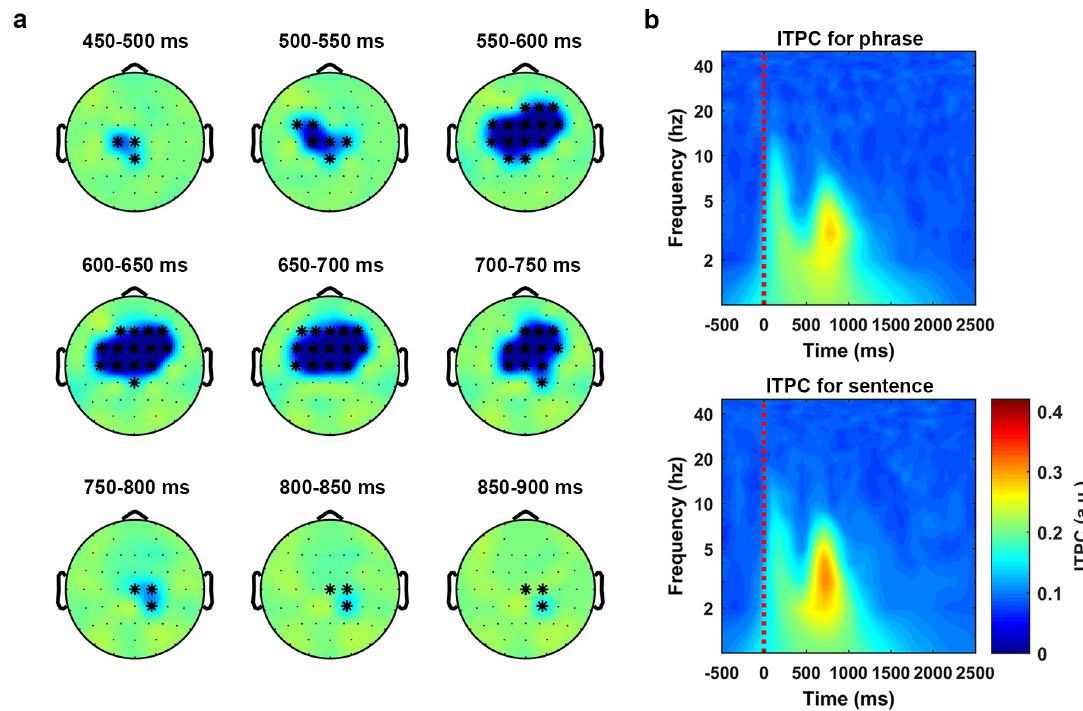
Fig 2. Phase coherence separates phrases and sentences at theta band. Statistical analysis on the phase coherence (ITPC) was conducted using a nonparametric cluster-based permutation test (1,000 times) on a 1,200-ms time window, which started at the audio onset and over the frequencies from 2 Hz to 8 Hz. The results indicated that the phase coherence was higher for the sentences than the phrases ( p < 1e-4 ��� , 2-tailed). (a) The temporal evolution of the cluster that corresponds to the separation effect. The activity was drawn using the ITPC of the phrases minus the ITPC of the sentences. The topographies were plotted in steps of 50 ms. (b) ITPC averaged over all the sensors in the cluster. The upper panel and the lower panel show the ITPC of the phrases and the sentences, respectively. ITPC, intertrial phrase